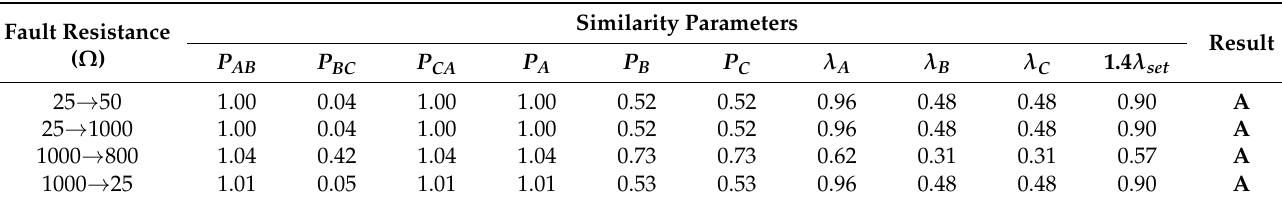
Table 6. Similarity parameters and faulty phase selection results under the influence of the sudden change of the fault resistance value. Fault